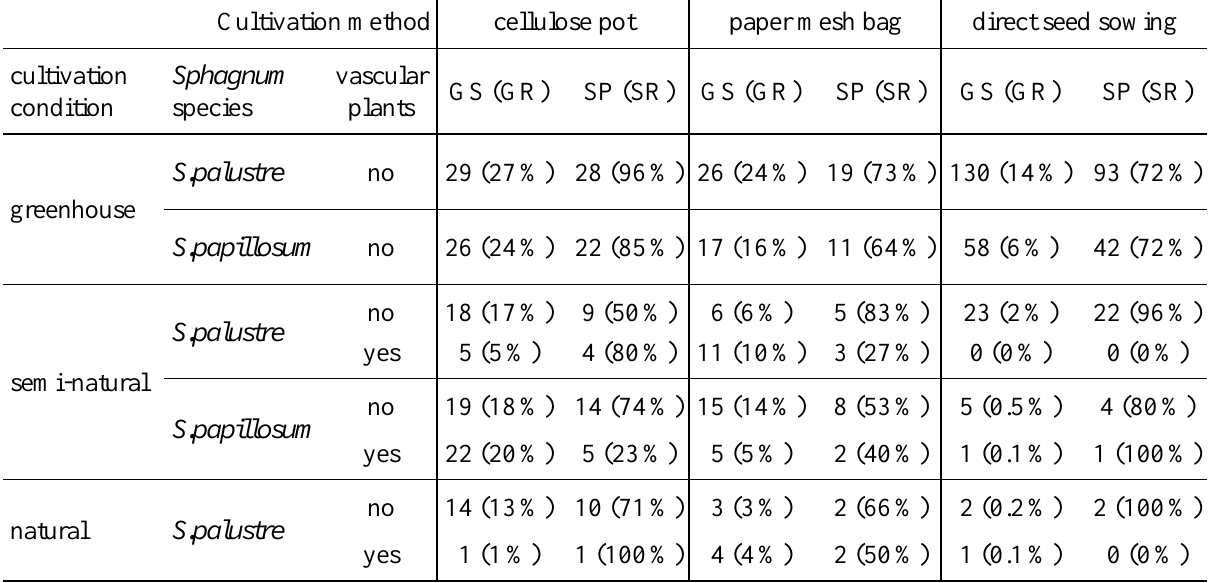
Table A4. Number of germinated seeds (GS) in September 2014 and number of surviving plants (SP) in August 2015 for the different cultivation conditions and methods. Total number of deployed D. rotundifolia seed per treatment = 108 (pots and bags) and 960 (seed sowing); vascular plants no = removed, vascular plants yes = not removed. In brackets: GR = germination rate; SR = survival